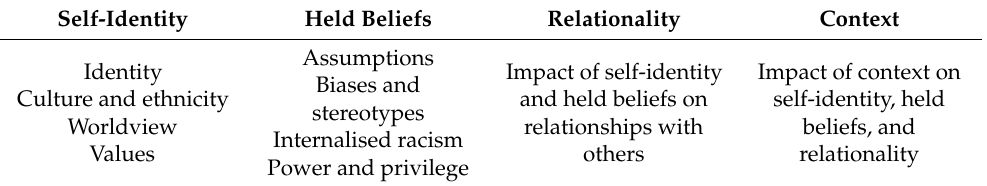
Table 2. How the purpose and focus of reflexivity is conceptualised: sub-themes identified in the data. Self-Identity Held